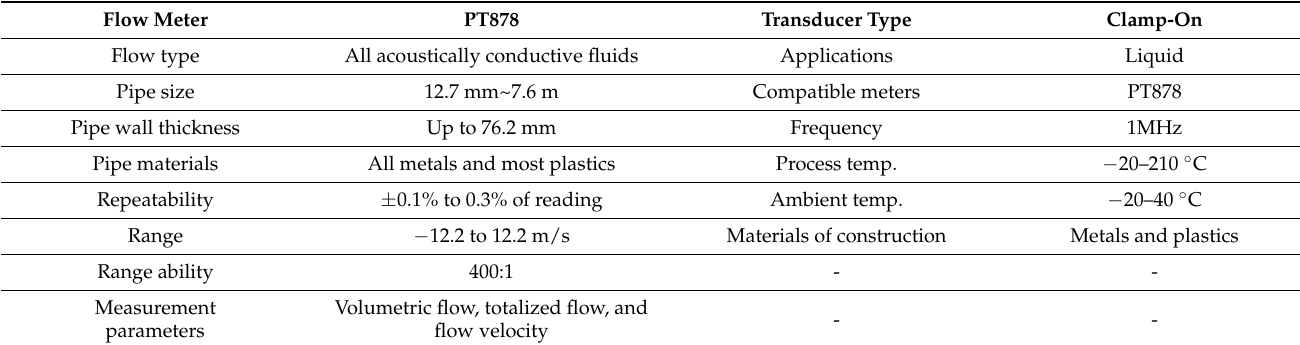
Table 2. Ultrasonic flow meter and transducer specifications.